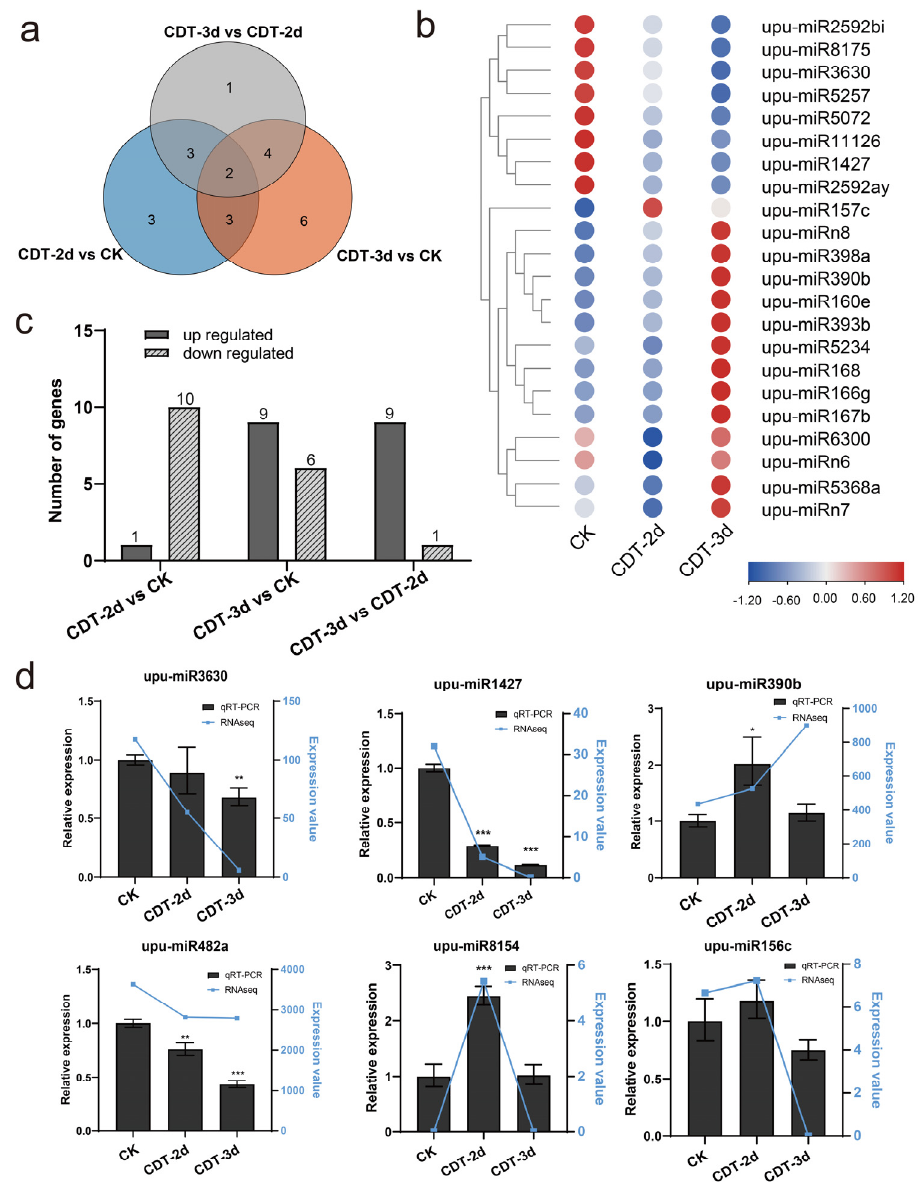
Figure 2. Differentially expressed miRNAs (DEMs) during seed aging in miRNAome and expression verification by qRT − PCR. CK, control check; CDT − 2d, seeds aged for two days; CDT − 3d, seeds aged for three days. ( a ) Venn diagrams show the number of common and specific miRNAs in comparison with the three libraries. The Venn diagram was plotted using TBtools v1.108. ( b ) Expression patterns of the DEMs based on deep − sequencing datasets. The blue − red bar at the bottom right of the heat map indicates the relative expression intensities. The darker the red color, the higher the expression, while the darker the blue color, the lower the expression. Expression pattern diagrams of miRNAs were plotted using TBtools v1.108. ( c ) The bar chart shows the number of up-regulated and down-regulated DEMs in comparison with the three libraries, with FDR ≤ 0.05, |log 2 FC| ≥ 1 as the threshold. The bar graphs were plotted with GraphPad Prism v8.0.1. ( d ) The comparison of qRT − PCR and the sequencing results of six miRNAs. A total of 5.8s rRNA of elm was used as an internal reference for miRNA. All reactions were repeated three times. Error bars indicate the standard deviation of three replicates. *, p < 0.05; **, p < 0.01; ***, and p < 0.001. The expression data by miRNAome sequencing are shown by the broken blue line for the sake of comparison.